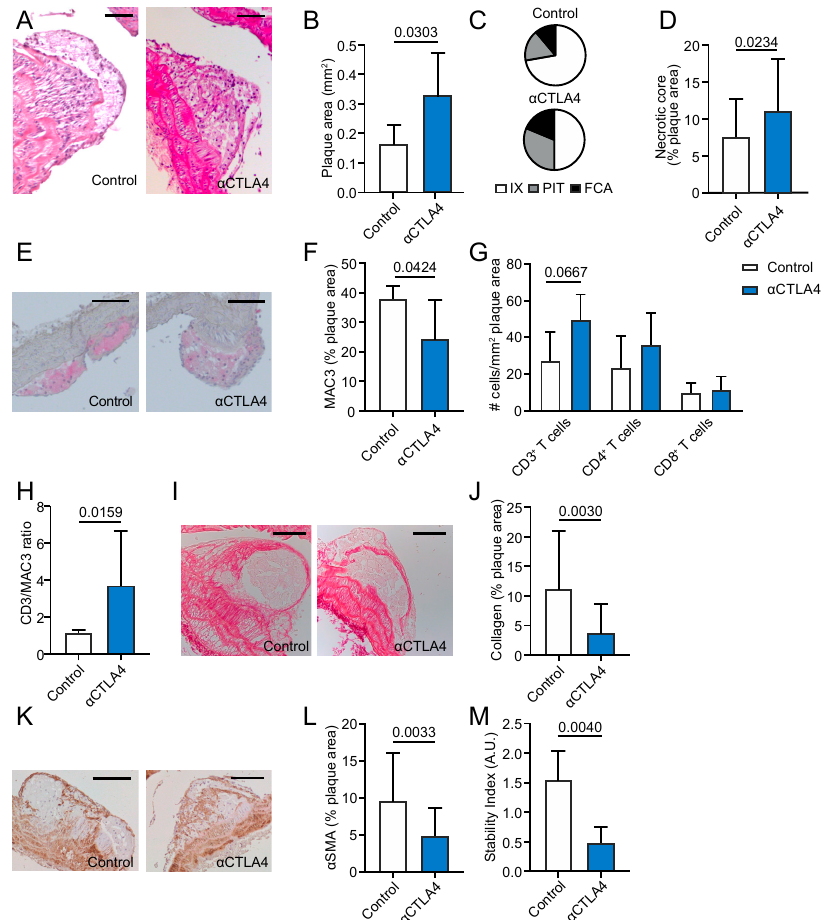
Figure 3. Antibody-mediated inhibition of CTLA4 aggravates initial atherosclerosis in the aortic arch. ( A ) Representative pictures of atherosclerosis in the brachiocephalic trunk (haematoxylin and eosin staining). Scale bar: 100 μ m. ( B ) Atherosclerotic plaque area in the aortic arch (n = 5–9). ( C ) Morphological analysis of the atherosclerotic plaque phenotype according to the Virmani Classification. ( D ) Quantification of necrotic core area in plaques. ( E ) Representative pictures of the plaque macrophage content. Scale bar: 100 µ m. ( F ) Quantification of plaque macrophage content. ( G ) Immunohistochemical quantification of CD3 + , CD4 + , and CD8 + cells. ( H ) The CD3 / MAC3 ratio in the plaques. ( I ) Representative pictures of plaque collagen content. Scale bar: 100 µ m. ( J )